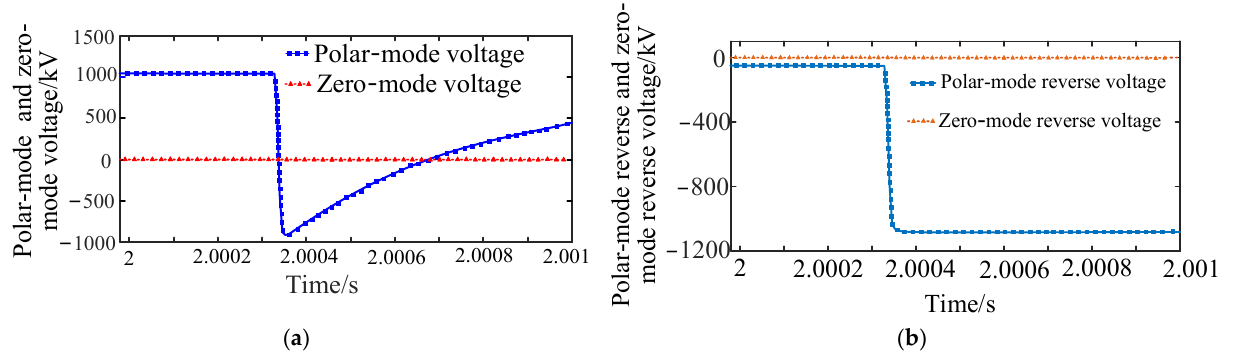
18 of 28 internal zone fault. The wavelet modulus maximum of the zero ‐ mode reverse ‐ voltage traveling wave under a negative fault is exactly the opposite of that under a positive fault. There is a wavelet modulus maximum at each scale, and the value is positive, at about 390 kV. Therefore, according to the fault pole selection criterion, the fault can be determined as a negative fault from the maximum value of the zero ‐ mode reverse ‐ voltage traveling wave wavelet modulus. − 400 − 2000 − 600 − 800 MMTW 1 ( b ) Figure 12. Wavelet transform results of maximum waveform in the negative pole to ground metal short ‐ circuit fault signal. ( a ) Polar ‐ mode reverse ‐ voltage traveling wavelet mode maximum wave ‐ form; ( b ) zero ‐ mode reverse ‐ voltage traveling wavelet mode extreme waveform. The simulation results of when a bipolar metallic ground short ‐ circuit fault occurs at the midpoint of DC line L 1 are shown in Figure 13. The occurrence of a bipolar short ‐ circuit fault results in an instantaneous drop of both the polar ‐ mode voltage and polar ‐ mode